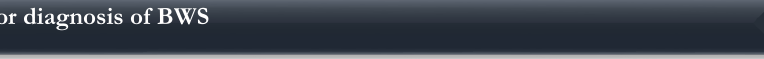
Table 2: Clinical criteria used for diagnosis of